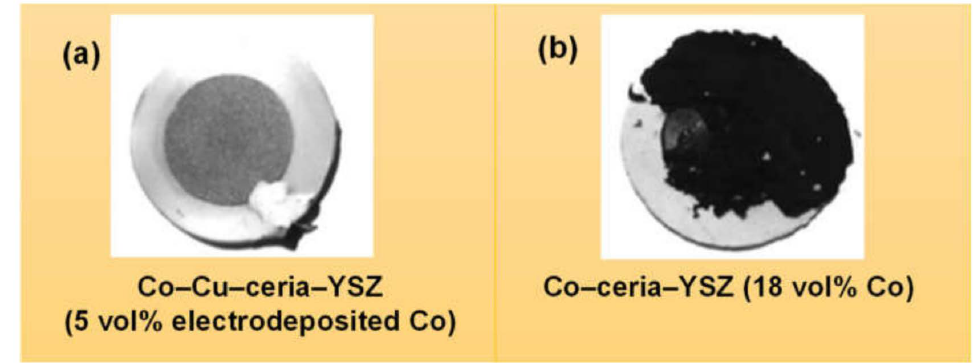
Figure 15. Photograph of the cells ( a ) after reduction in dry H 2 at 800 ◦ C and ( b ) exposure to dry CH 4 for 3 h at 800 ◦ C (adapted from